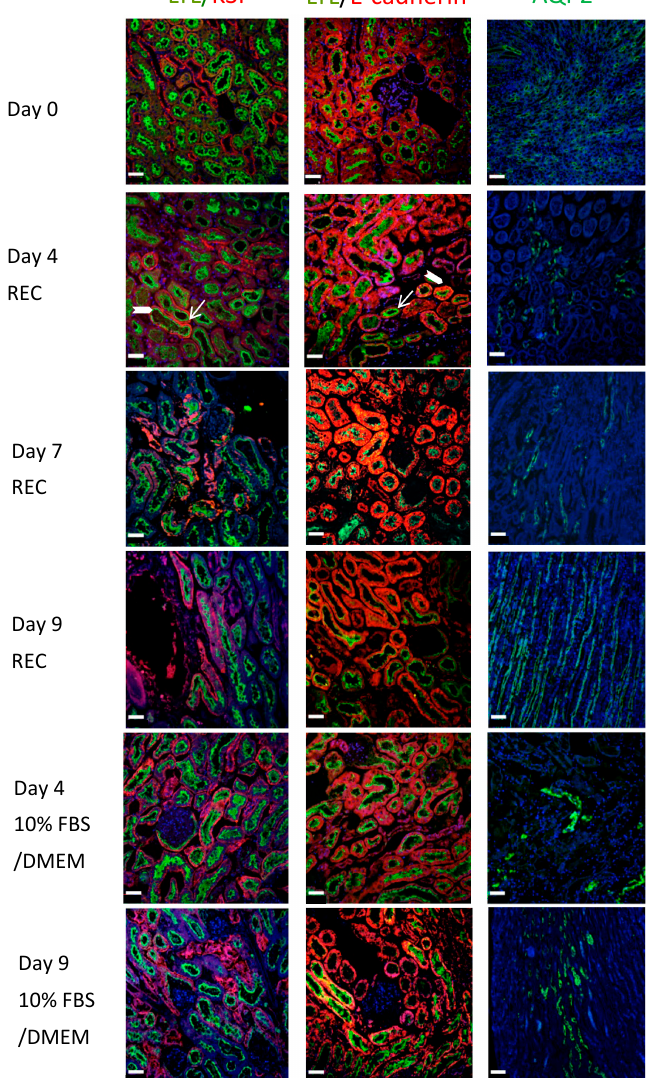
Figure 4. Tubule and collecting duct staining depicts healthy kidneys. Control kidney, cannulated but not perfused. LTL (green), KSP (red) double positive depict proximal tubules. E-cadherin (red), double positive with LTL depicts distal tubules. AQP2 (green) depict collecting ducts. Kidneys perfused with Renal Epithelial Medium for 4, 7, 9 days demonstrated healthy tubules and collecting ducts. Kidneys perfused with 10%FBS/DMEM for 4, 9 days demonstrate healthy tubules and collecting ducts. Day 9 morphology is intact. Block arrows = LTL, Arrow = KSP or E-cadherin. Bar = 45 µ